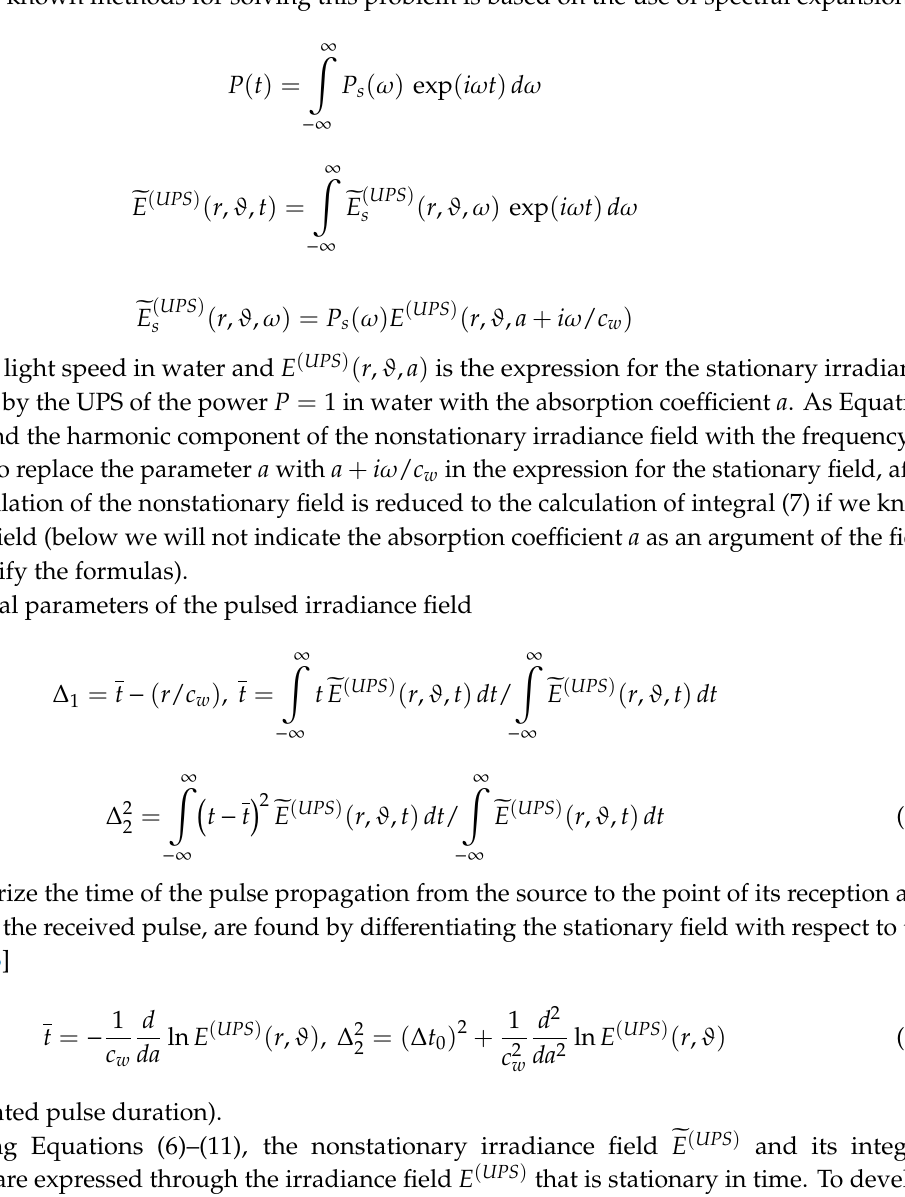
Figure 1. Schematic representation for the unidirectional ( a ) and omnidirectional ( b ) light point sources.